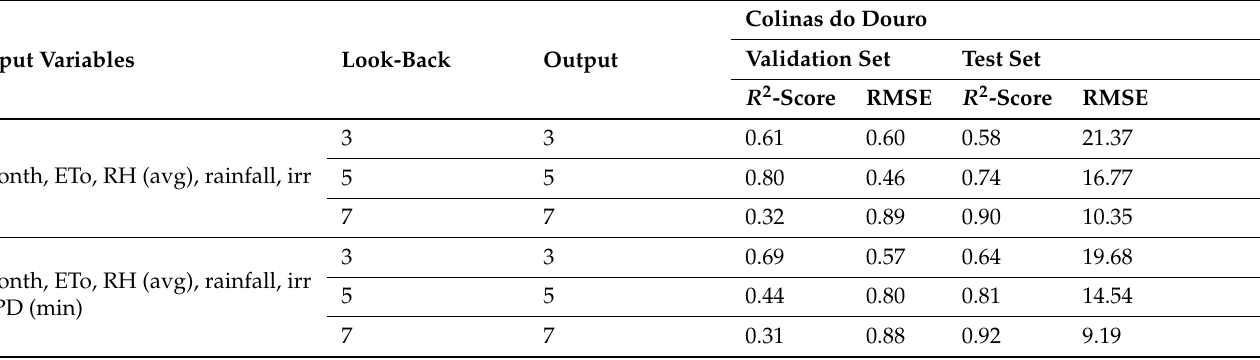
Figure 9. Comparison between the observed and predicted values of the FTSW. The results of the model with the Vapor Pressure Deficit (VPD) as the input are shown in ( a , c ), while the results of the model without this variable as the input are shown in ( b , d ). A perfect fit is represented as a yellow line. Table 6. The performance of the BiLSTM-trained model to predict the FTSW with different look-backs and lengths of the